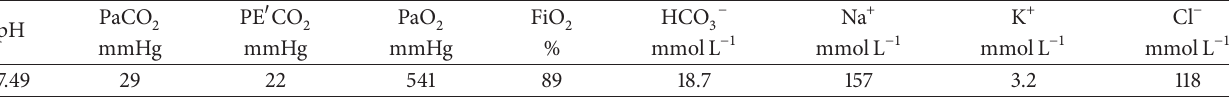
Table 1: Arterial blood gas collected taken from a dog with hiccup-like response while anesthetized with isoflurane in oxygen 100%. PaCO 2 : arterial carbon dioxide partial pressure; PE 󸀠 CO 2 : end-expiratory partial pressure of carbon dioxide; PaO 2 : arterial oxygen partial pressure; FiO 2 : inspiratory fraction of oxygen; HCO 3− : bicarbonate; Na + : sodium; K + : potassium; Cl − :